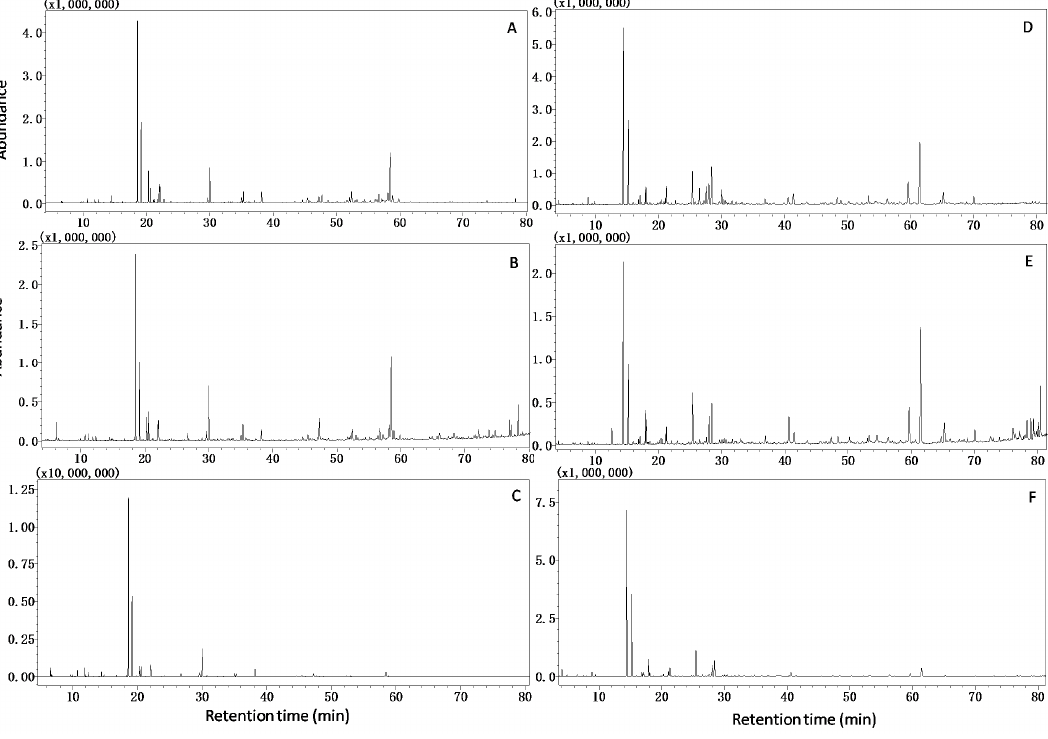
Figure 1. Typical GC-MS total ion current (TIC) chromatograms of Rxi-5MS (( A ) HD; ( B ) MAE; ( C ) HS) and HP-INNOWAX (( D ) HD; ( E ) MAE; ( F ) HS).